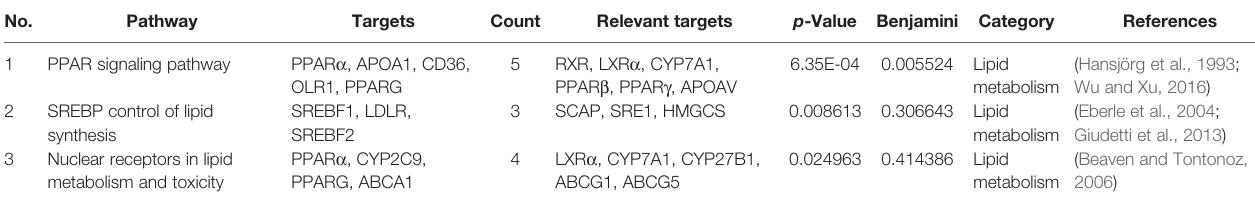
TABLE 4 | The detail information of three pathways mainly involved in lipid metabolism. No. Pathway Targets Count Relevant targets p -Value Benjamini